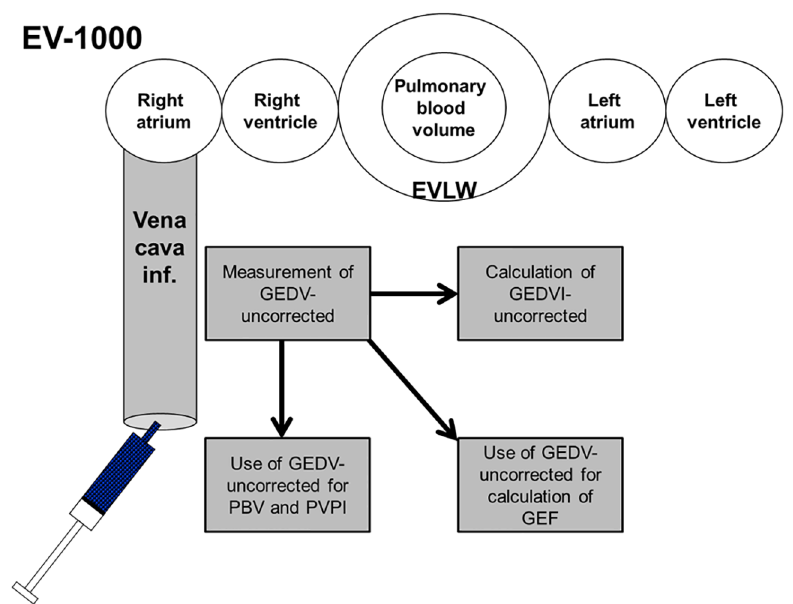
Fig 3. Algorithm assumed for the calculation of GEDV, GEDVI, PBV, PVPI and GEF as displayed by the EV-1000[5]. Confounders (volumeof VCI) and confounded values with marked deviationdeviationfrom corresponding measurements using jugularaccess (PBV, PVPI_fem) are shaded. The EV-1000 does not correct any parameter derived from femoral CVC indicatorinjection. GEDV(I): globalend-diastolic volume (index) PBV: pulmonary blood volume PVPI: pulmonary vascular permeability index GEF: globalejectionfraction